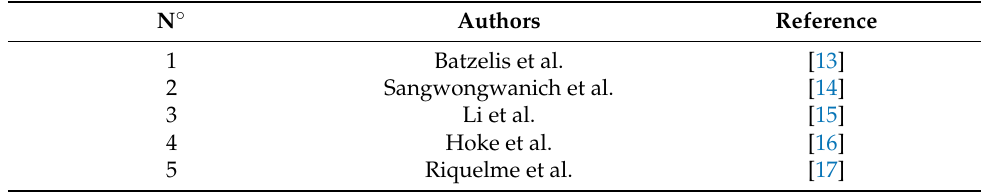
Table 1. Summary of reviewed articles about Power Reserve Control of PV